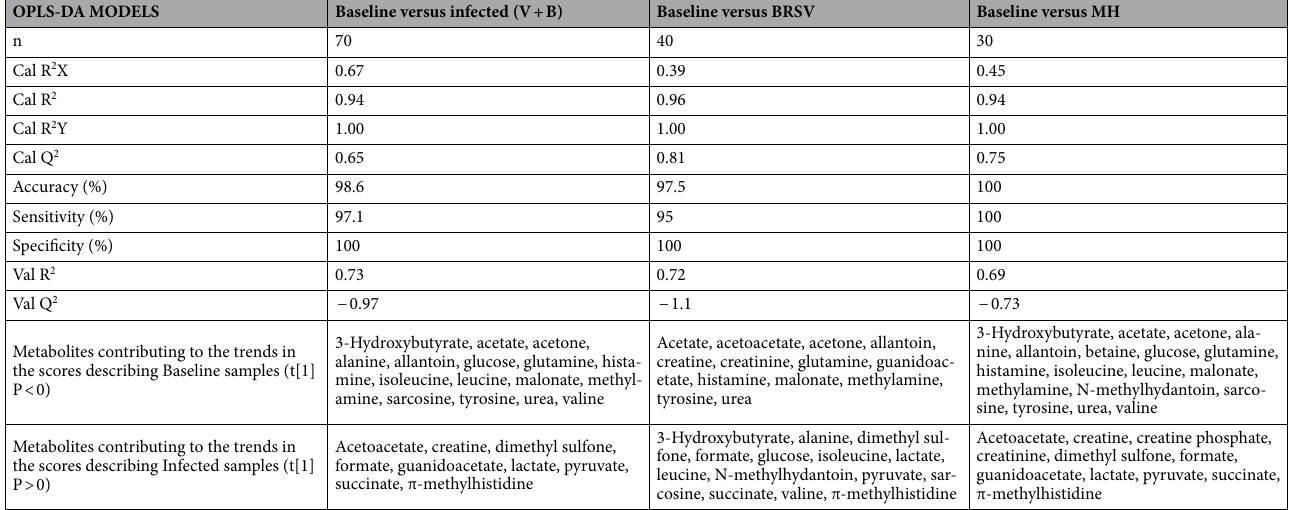
Table 5. OPLS-DA model quality parameters for the classification of 1 H-NMR spectra from plasma collected before and after the controlled infections. Cal = calibration, Val = validation, R 2 X = degree of optimization, R 2 = coefficient of determination, R 2 Y = percentage of variation explained by the model, and Q 2 = cumulative prediction, t[1]P = first principal